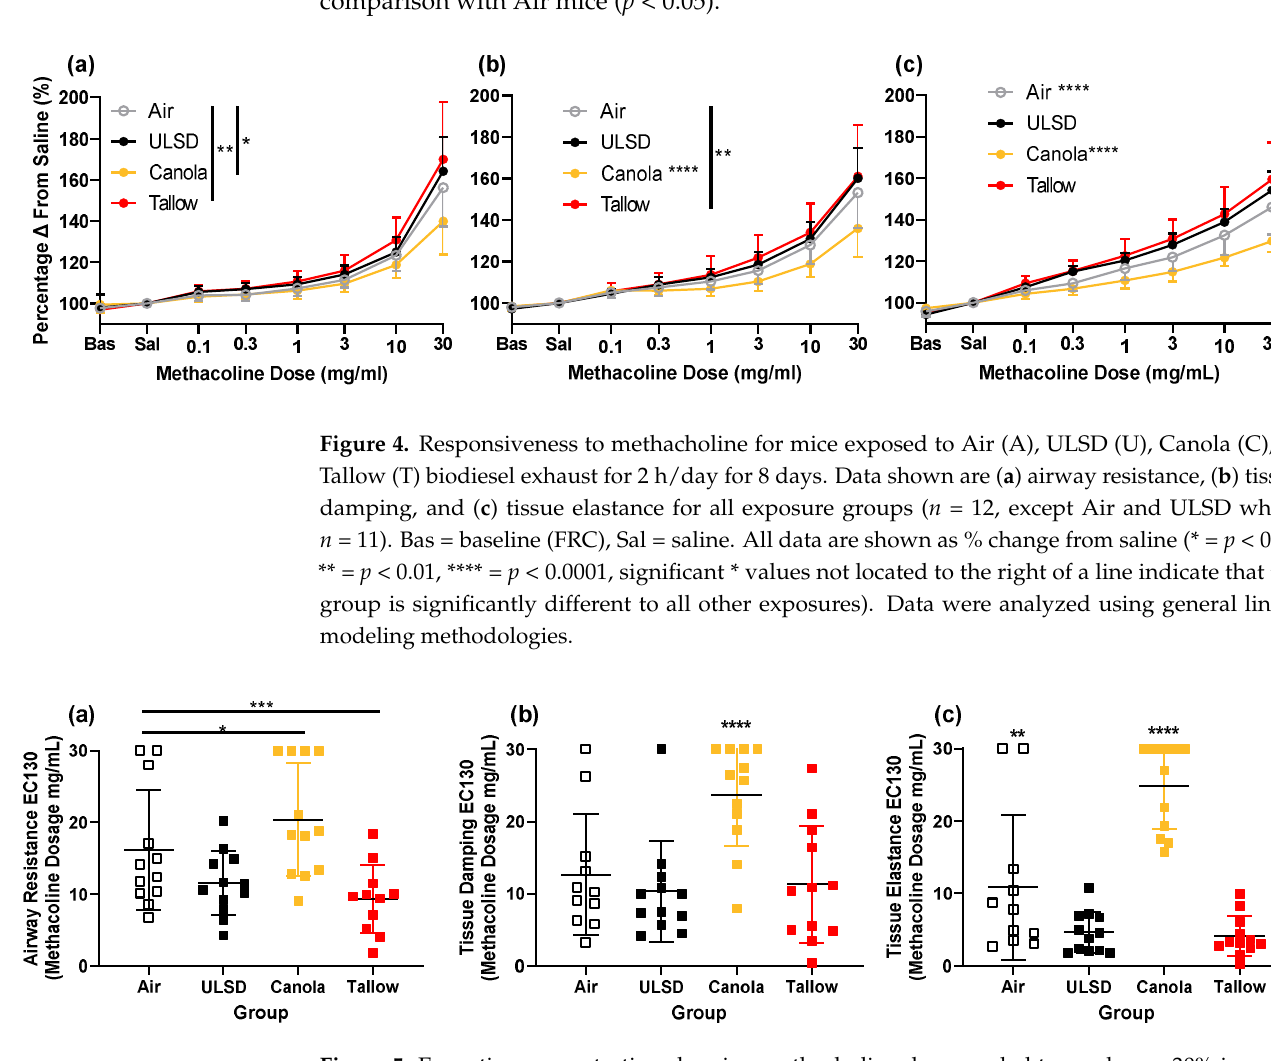
Figure 5. Evocative concentration showing methacholine dose needed to produce a 30% increase from saline in ( a ) airway resistance, ( b ) tissue damping, and ( c ) tissue elastance in mice exposed to Air, ULSD, Canola, or Tallow biodiesel exhaust for 2 hr/day for 8 days ( n = 12, except Air and ULSD where n = 11) (* = p < 0.05, ** = p < 0.01, *** = p < 0.001, **** = p < 0.0001, significant * values not located next to a line indicate that the group is significantly different to all other exposures). Data were analyzed using general linear modeling